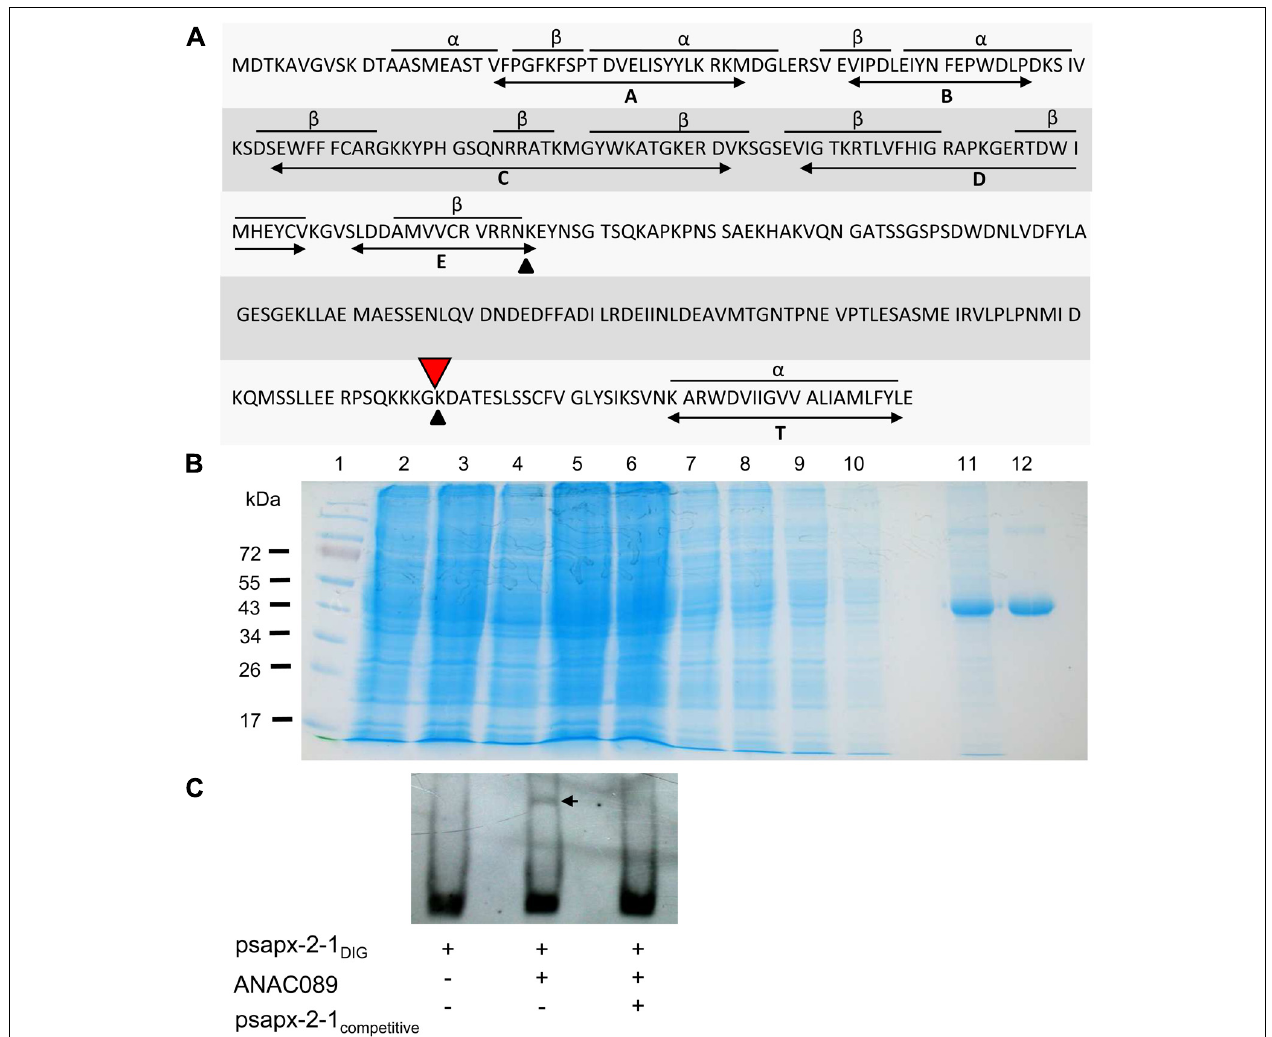
FIGURE 3 | Structure ofANAC089, generation of recombinant His 6 -ANAC089 and EMSA. (A) Primary structure of the ANAC089 transcription factor.The N-terminal ANAC domain consists of three α -helices and eight β -sheets in conserved arrangement (A–E).The bioinformatically predicted transmembrane α -helix (T) of the ANAC089 protein is localized at amino acid position 319–339. Putative protein cleavage sites are indicated with arrows. His 6 -ANAC089 was expressed in E. coli and purified by Ni-NTA affinity chromatography. (B) Heterologous expression and purification of His6-tagged ANAC089.The recombinant ANAC089 protein was expressed in BL21 (DE3) pLysS E. coli cells which were induced with 400 μ M isopropyl- β - D -thiogalactopyranoside for 4 h. By SDS PAGE the time-dependent